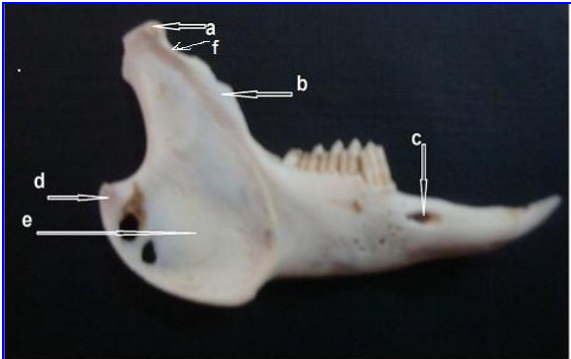
Figure, 4: The lateral surface of the mandible of the local rabbit. (a) condyloid process (b)coronoid process (c) mental foramen (d)angular process (e) ramus (f) mandibular